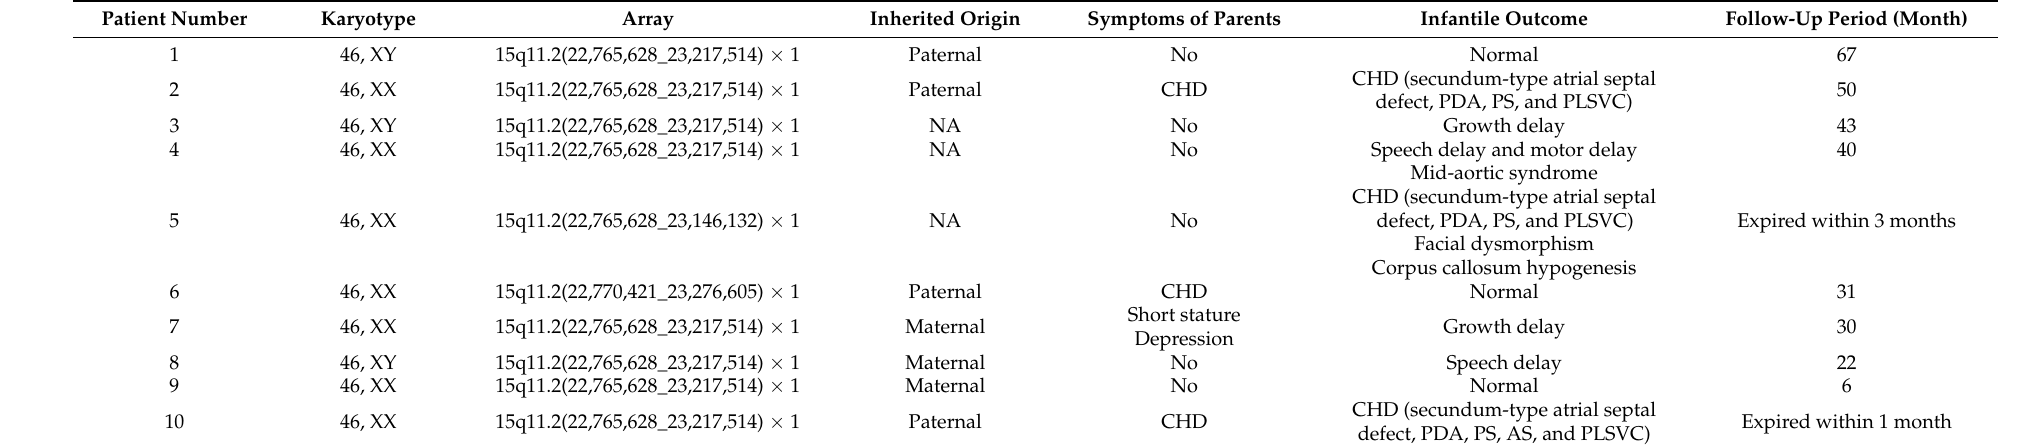
Table 1. Clinical characteristics of children diagnosed with 15q11.2 BP1–BP2 microdeletion.